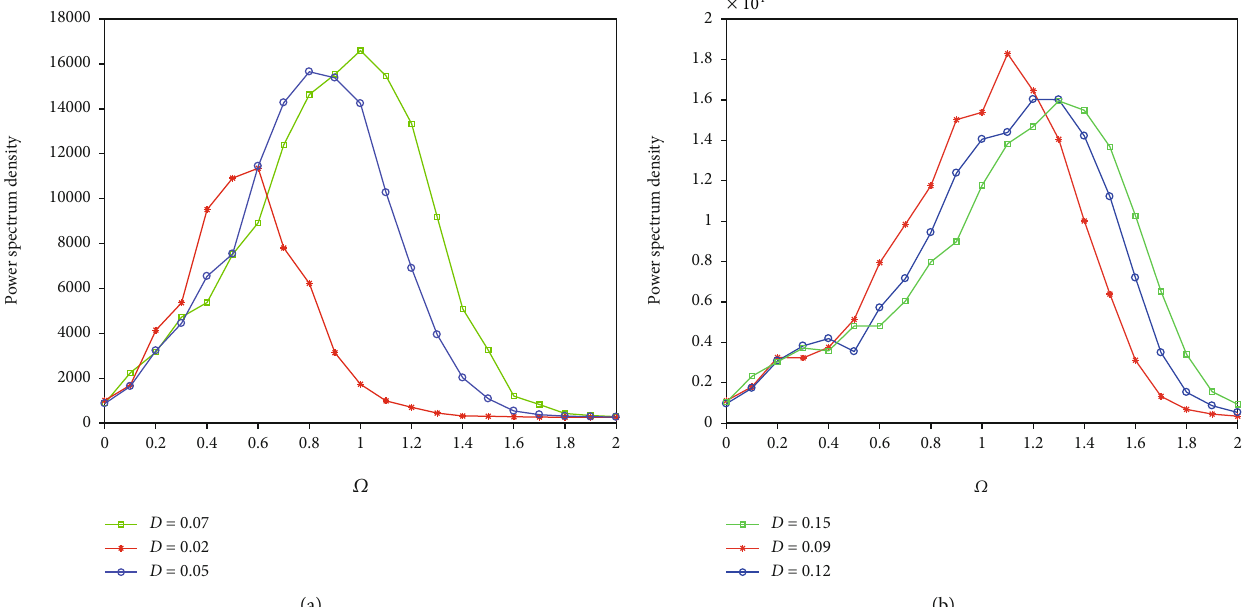
Figure 4: The relationship between Ω and system output PSD of undamped bistable system driven by the harmonic noises. (a) Input white noise intensity D = 0 : 02 , 0.05, and 0.07. (b) Input white noise intensity D = 0 : 09 , 0.12, and 0.15.